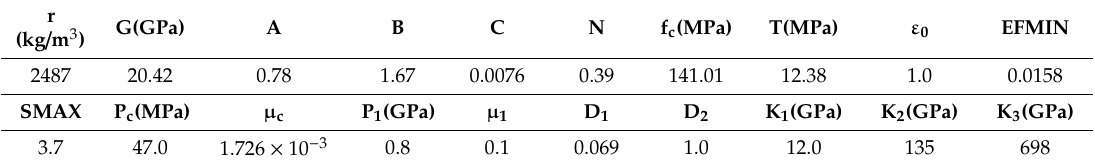
Table 1. Calculation parameters of the C130 concrete HJC (Holmquist-Johnson-Cook) constitutive model.